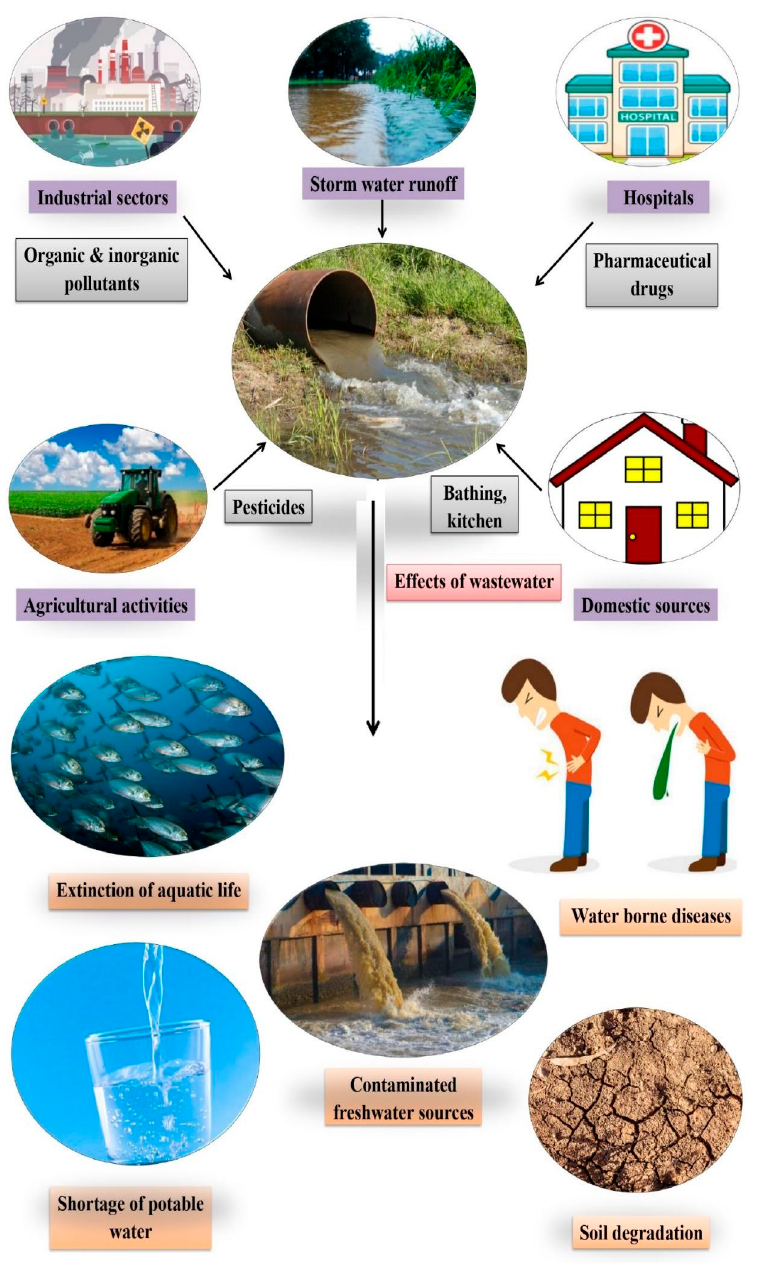
Figure 1. Different sources of wastewater, and its adverse effects on the environment and society.